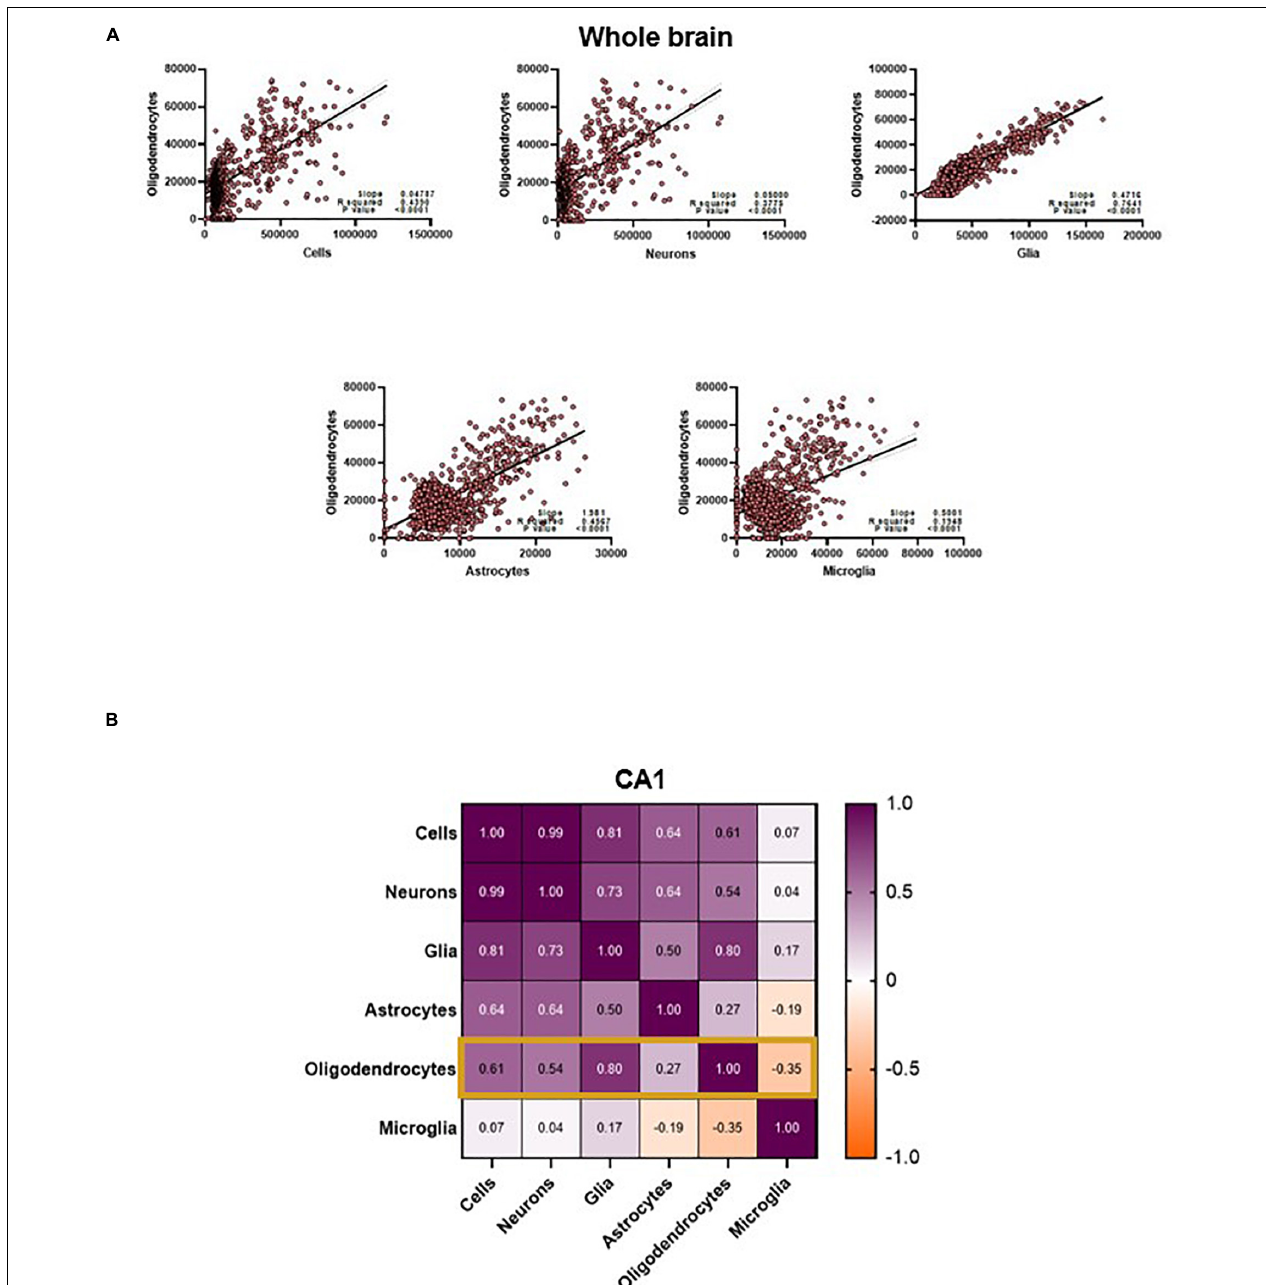
FIGURE 6 | (A) Oligodendrocyte counts are highly correlated to other cell counts in the whole brain. (B) CA1 oligodendrocyte counts are only strongly correlated to counts of Cells, Neurons and total glia. Values in the matrix represent Pearson R coefficients. “Cells” represent counts of all cell types studied, and “Glia” is the sum of oligodendrocyte, astrocyte and microglia